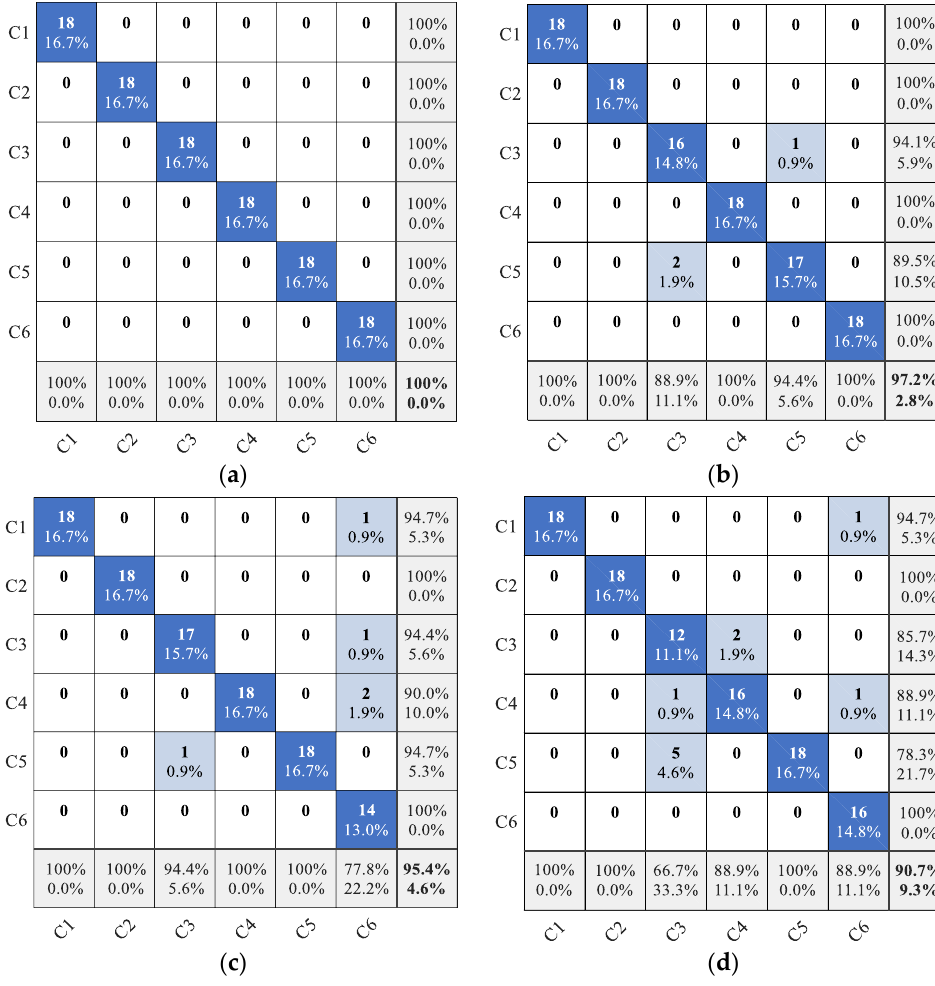
Figure 8. ( a ) VMD + MSE + CNN timber damage identification results; ( b ) ALIF + MSE + CNN timber damage identification results; ( c ) EEMD + MSE + CNN timber damage identification results; ( d ) EMD +